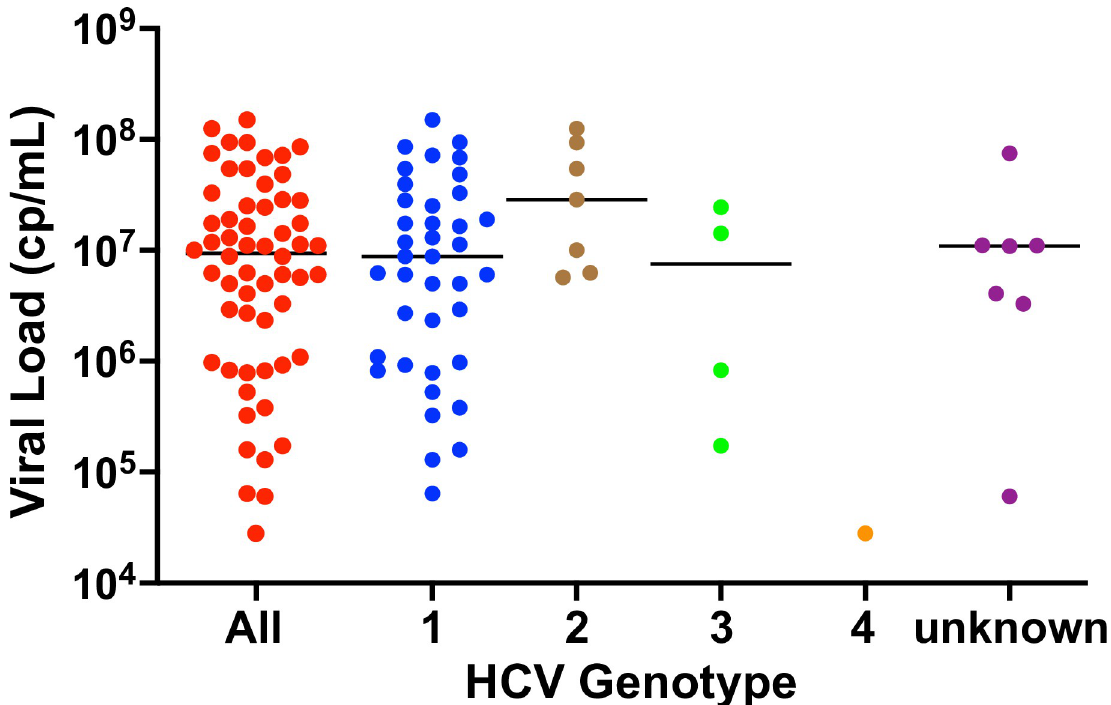
Fig 3. Viral load distribution of HCV clinical samples. Viral loads of clinical samples used in this study were measured using RT-qPCR on freshly extracted RNA from serum samples (GiCasRes biorepository). The measurements are stratified by genotype on the x-axis, and the black horizontal bar represents the median. We evaluated a total of 58 HCV-positive samples representing genotypes 1–4, and 7 samples lacking a paired genotype test.